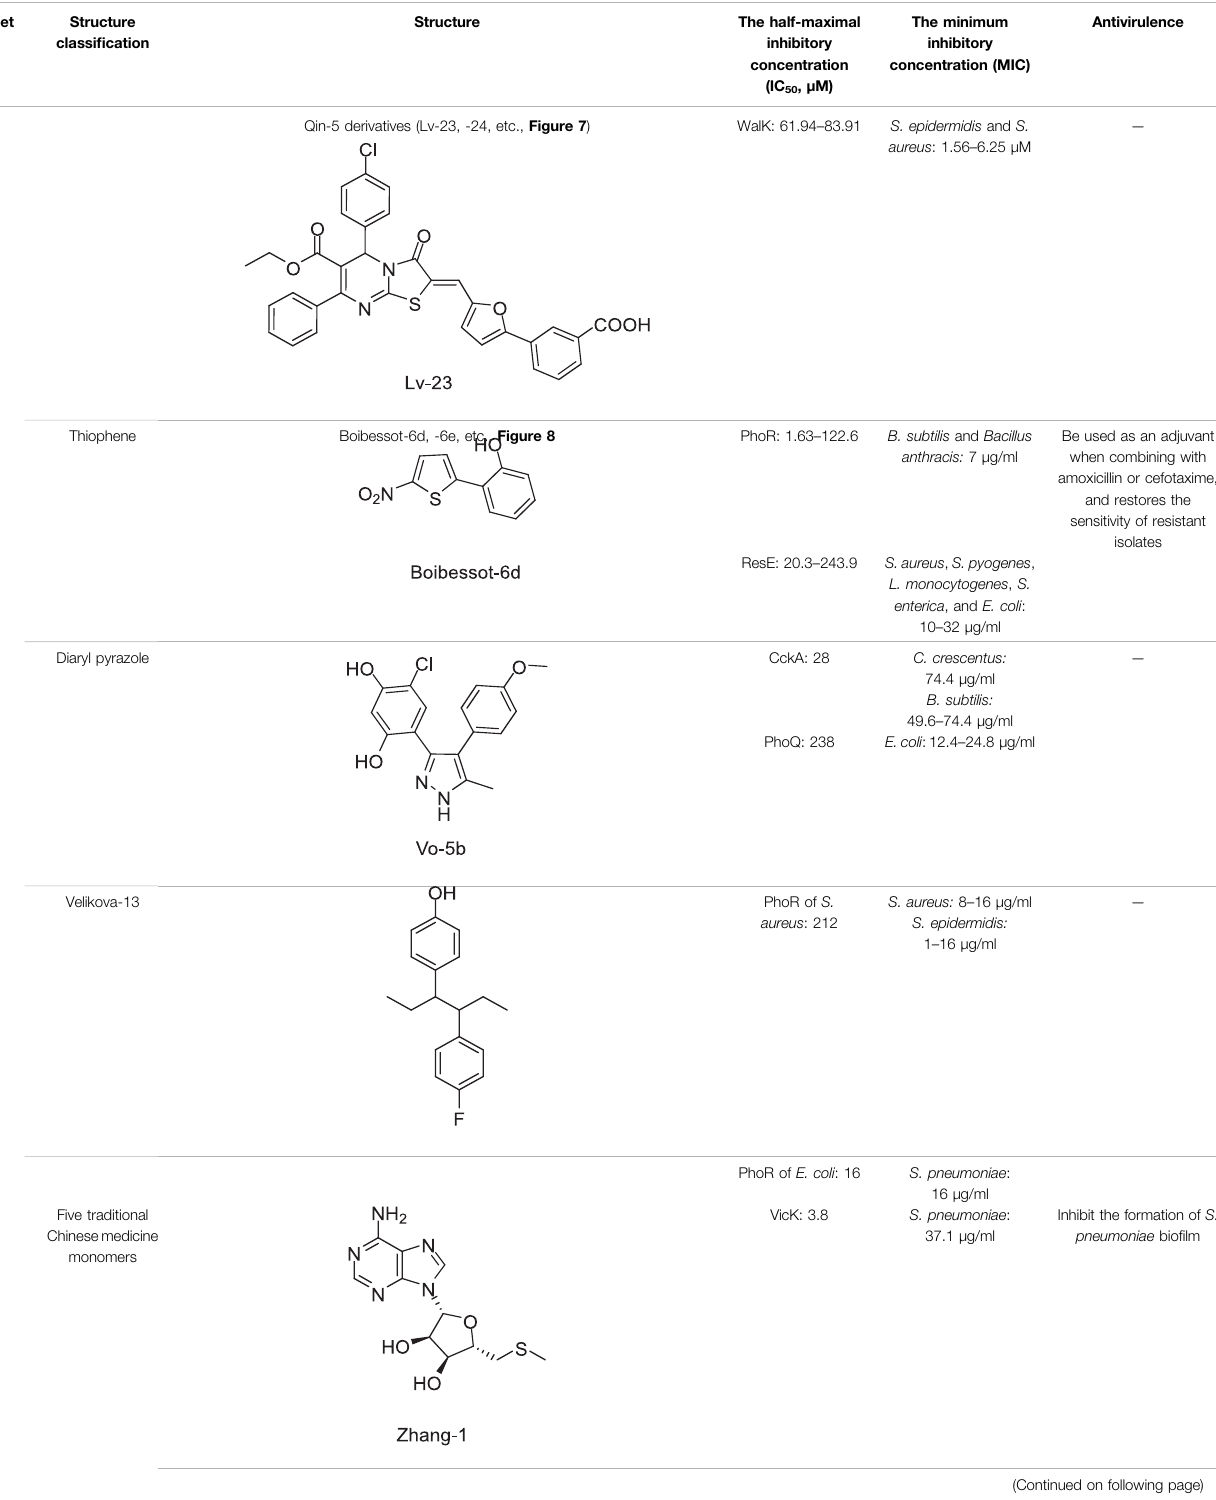
TABLE 4 | ( Continued ) The summary of HK